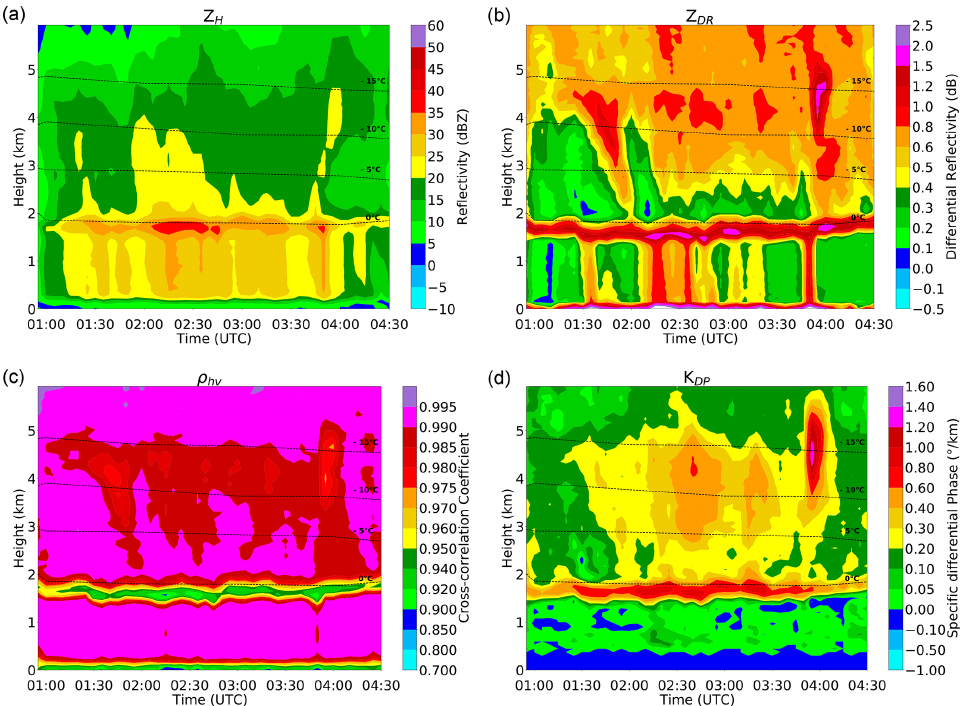
Figure 2. RSVPs of Z H (a) , Z DR (b) , ρ hv (c) , and K DP (d) using measurements from the DOW on 18 December 2015 between 00:40 and 04:30UTC. The time interval shown is equal to the flight mission length to the nearest 15min. Data in the RSVPs are at ranges from 6.5 to 11km away from the radar and 22 ◦ in azimuth. The overlaid dashed lines (in all panels) display the 0, − 5, − 10, and − 15 ◦ C isotherms from European Centre for Medium-Range Weather Forecasts Reanalysis v5 (ERA5; Hersbach et al., 2020) at the DOW